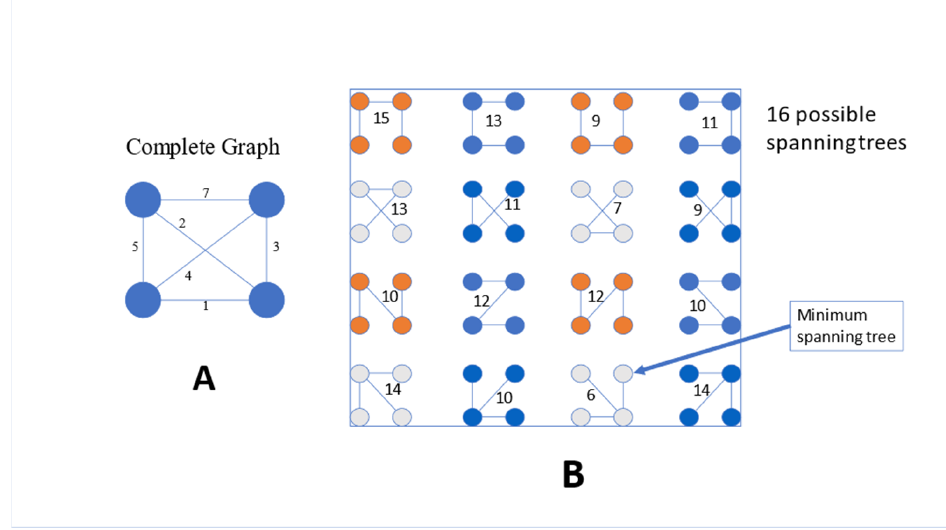
Figure 1. Minimum spanning tree: ( A ) a complete graph in which all points are connected and ( B ) 16 possible spanning trees. ( B ) 16 possible spanning